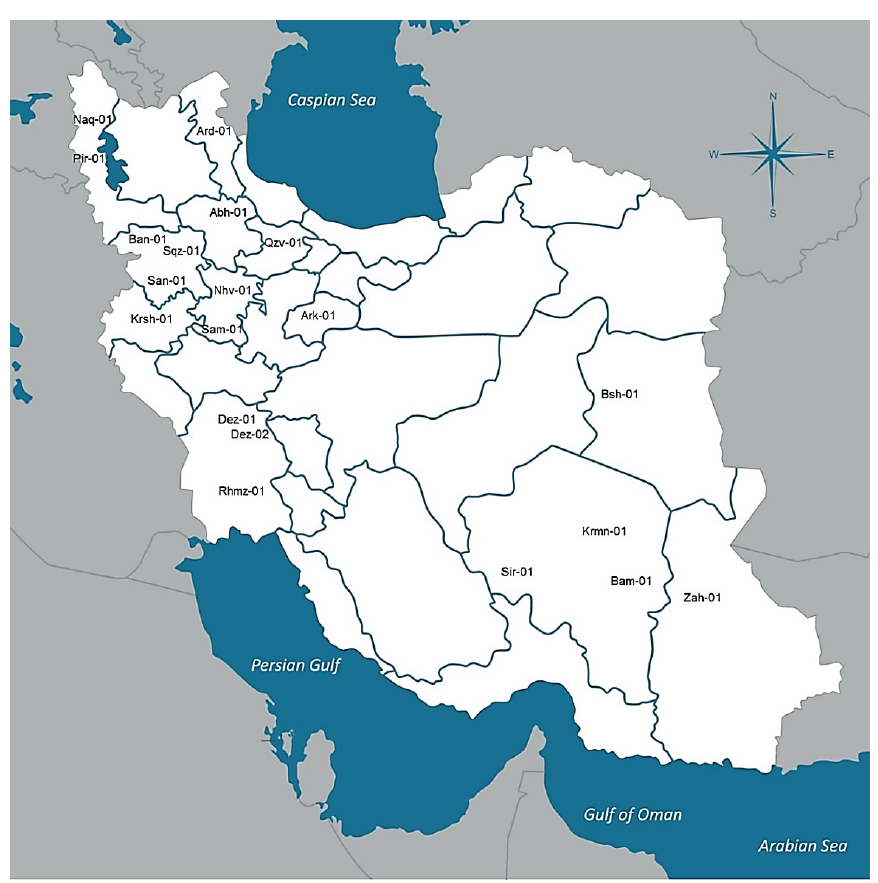
Figure 5. Geographical distribution of 20 distinct cannabis populations across selected regions of